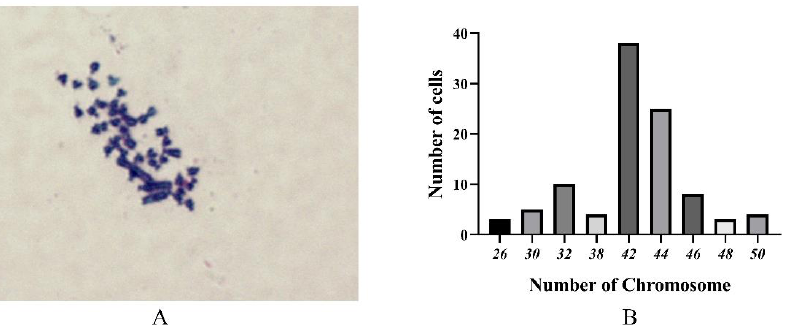
Figure 3. Chromosome morphological features and frequency distribution of TAH-11-11 cells: ( A ) chromosome morphology of TAH-11 cells at Passage 50; ( B ) chromosome numbers were counted in colchicine-treated TAH-11 cells at Passage 50.